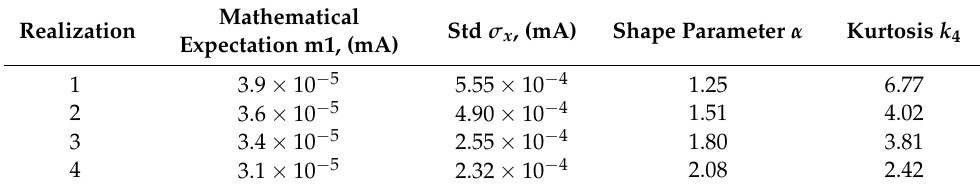
Table 2. Statistical moments of noise.